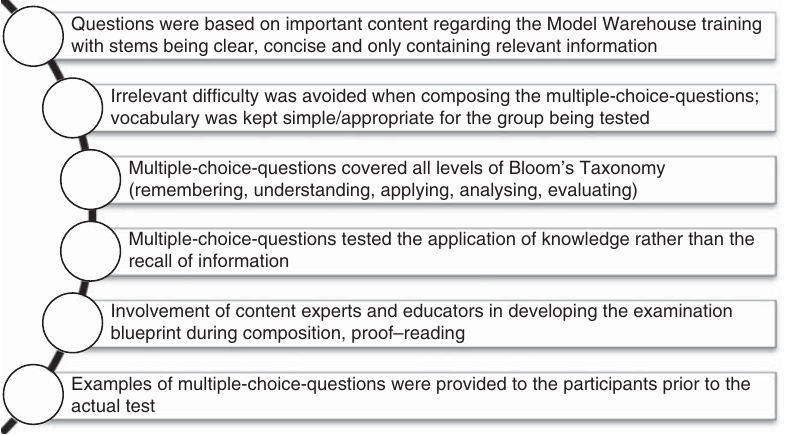
Figure 2. Steps taken to